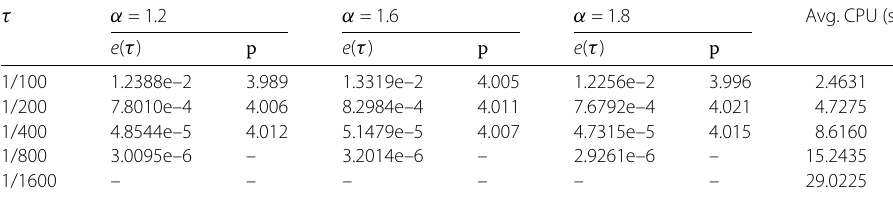
Table 2 Convergence rates of the ETDRK4-P13 scheme in time τ α = 1.2